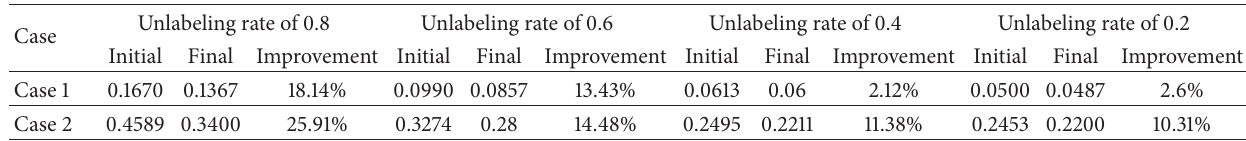
Figure 4: Faults of inner ring, outer ring, and roller element. Table 5: Classification error rate of initial and final hypothesis and the corresponding improvements of C-tritraining under different unlabeling rate with suspect principle value set to 4.